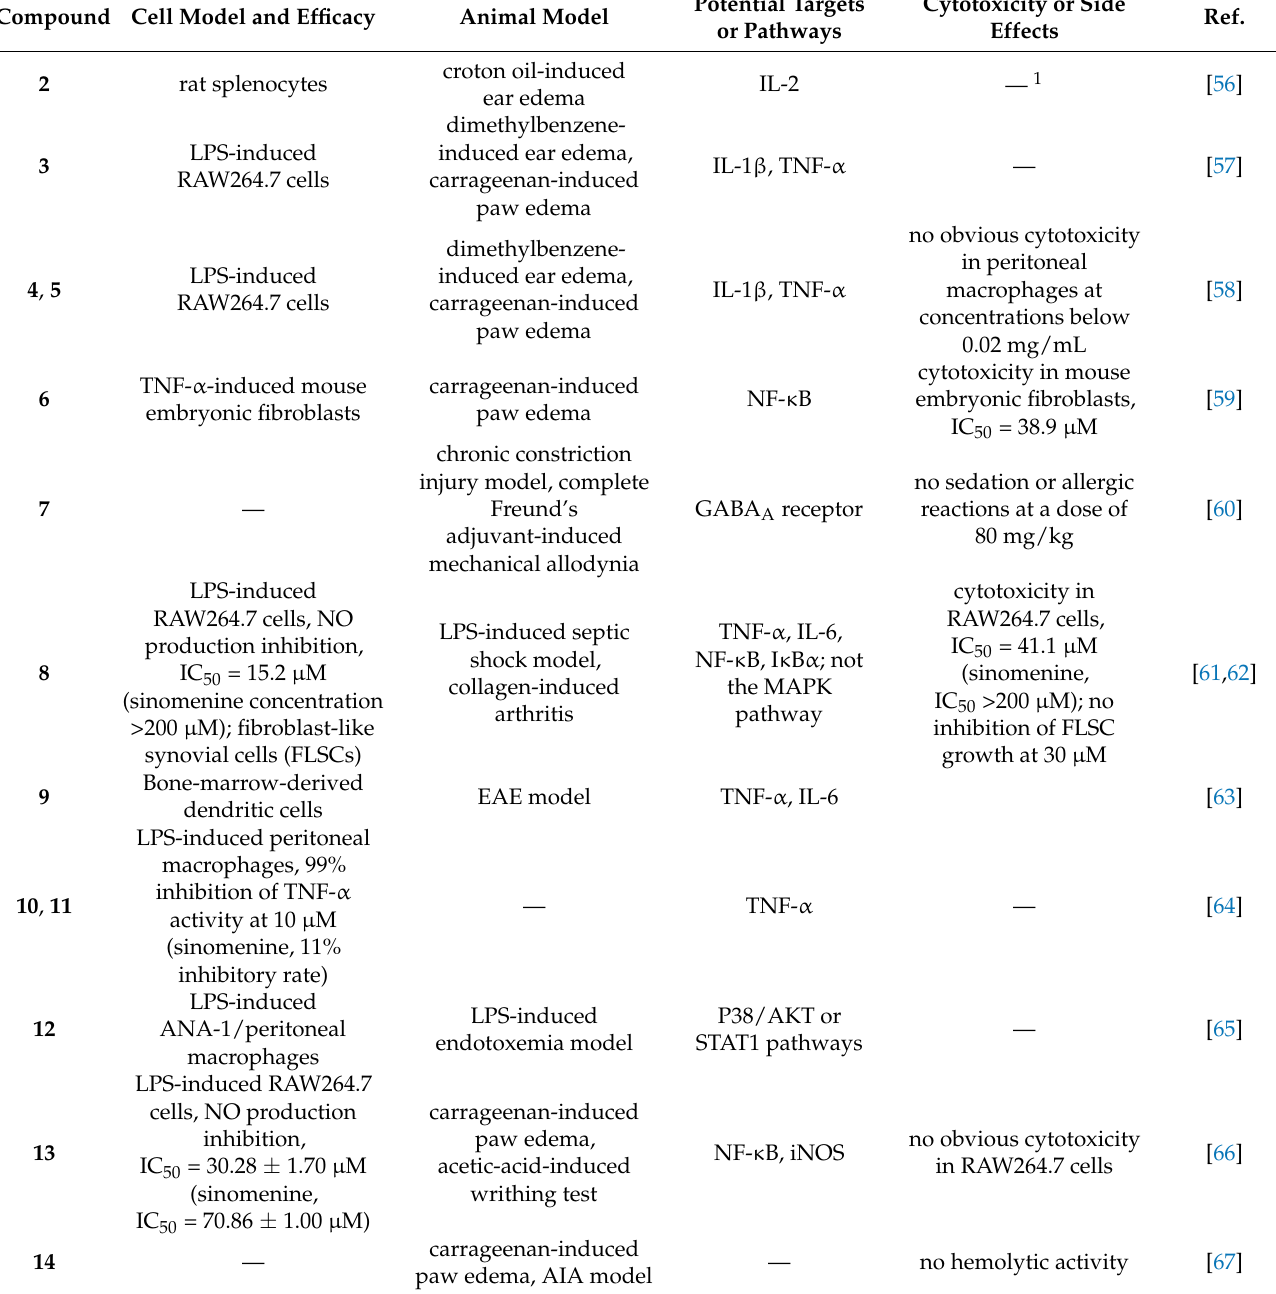
Table 1. The anti-RA activities of sinomenine